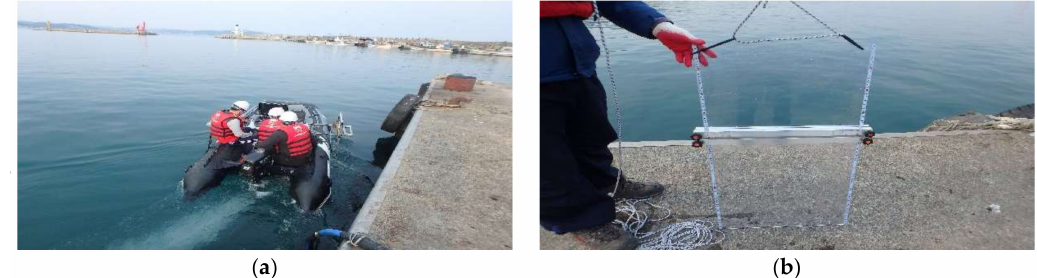
Figure 5. Field test for resolution. ( a ) Side Scan Sonar operation; ( b ) Specimens.